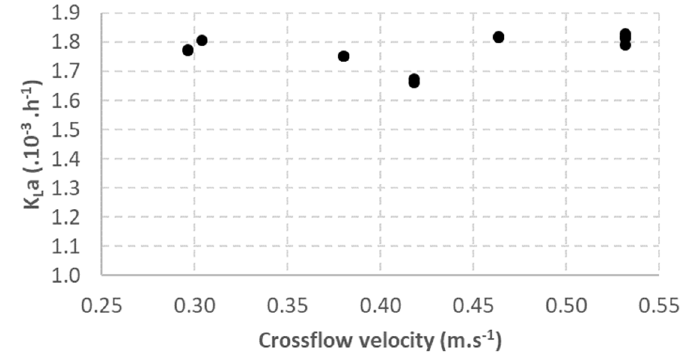
Figure 4. Impact of crossflow velocity on K L a.